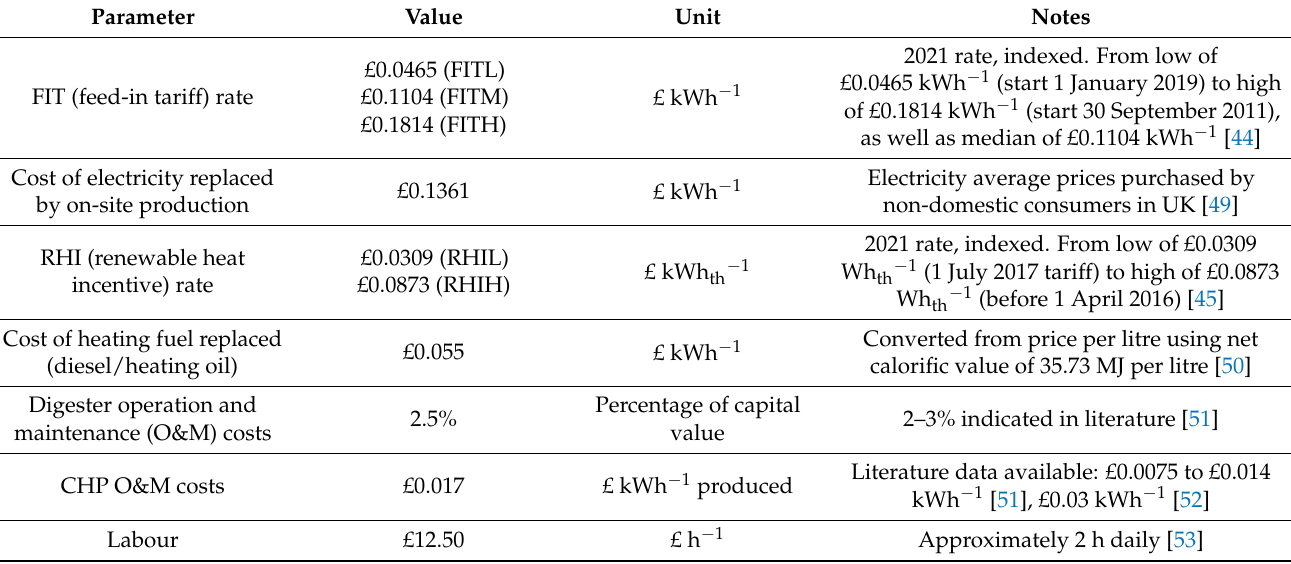
Table 2. Economic model parameter